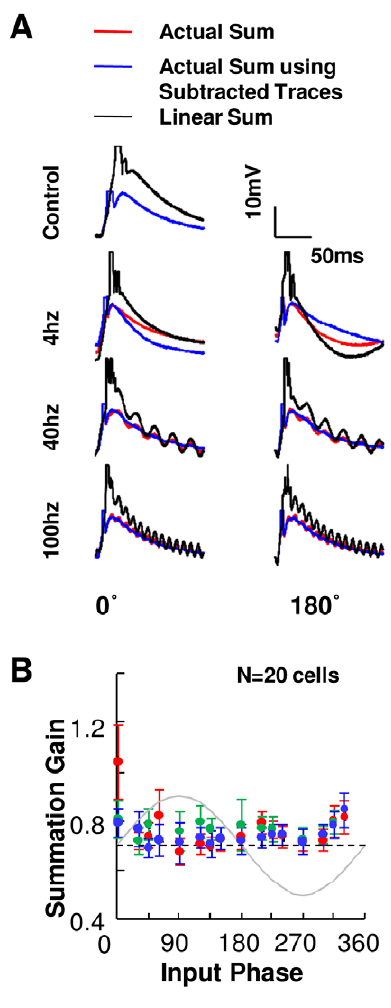
Figure 7. Summation Gain robust to Rhythmic Input Shapes Transmission. ( A ) Example traces (cell # 010410s2_c3) show response to multiple inputs (red) for 2 input phase values of 0 and 180 degrees. Linear sum shown in black, the actual summed response shown in red and the sinusoid subtracted summed responses in blue. ( B ) Summation gain (N=20 cells) measured as a ratio of sinusoid subtracted EPSP area for multiple inputs to EPSP area for sum of single inputs. On subtracting the best fit sinusoid from the responses, there is no significant phasic modulation with either theta or gamma frequency current injection. Error bars represent SE. The gray trace shows the somatic current injected at the input phases.